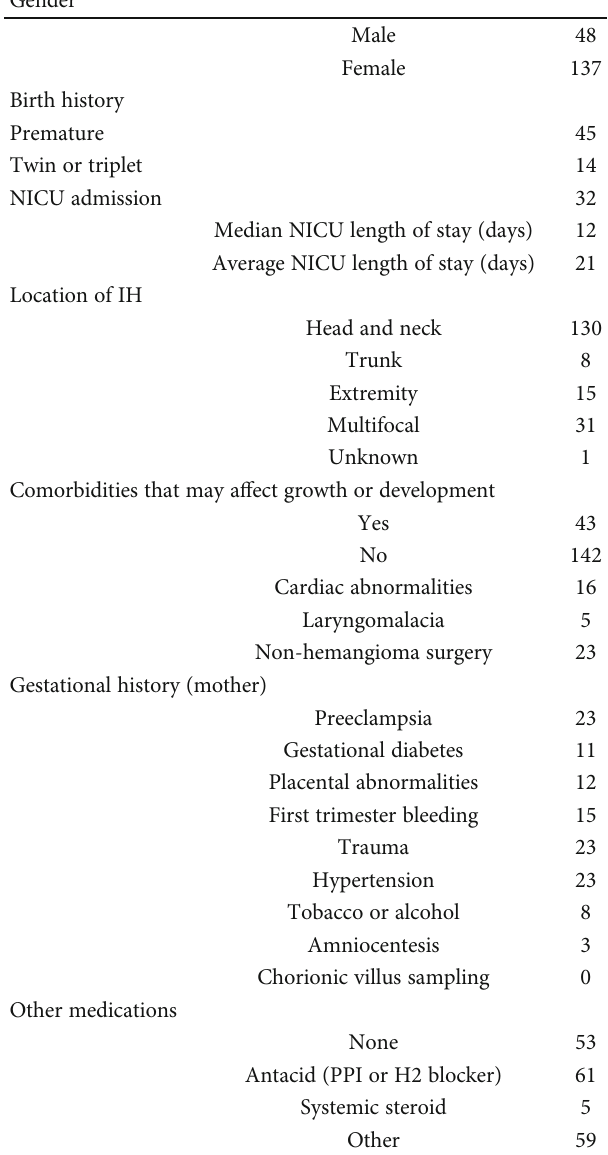
Table 1: Patient